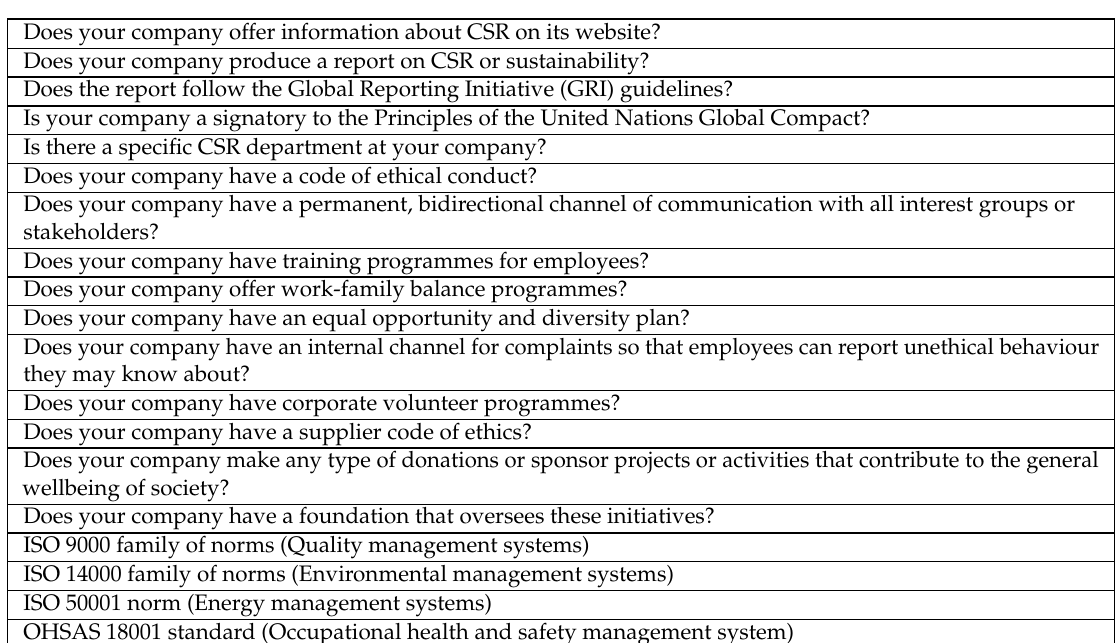
Table 1. Indicator of Corporate Social Responsibility (CSR) Practices: Possible Actions.